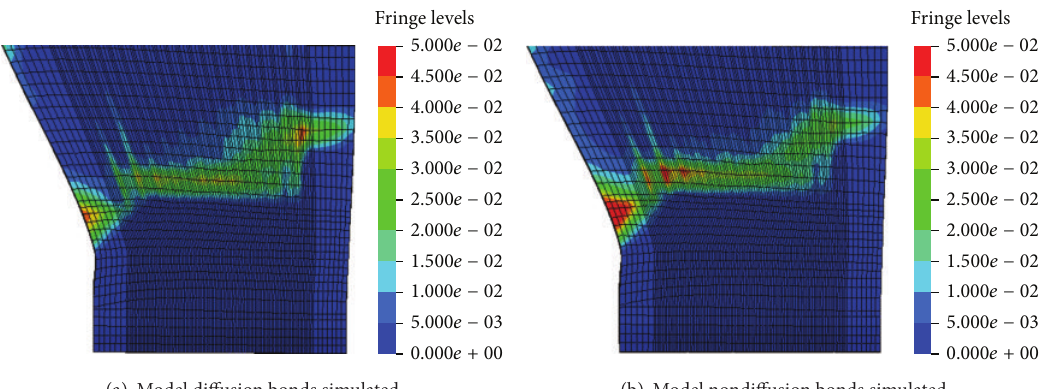
Figure 12: Contour plots of effective plastic strain near blade root.